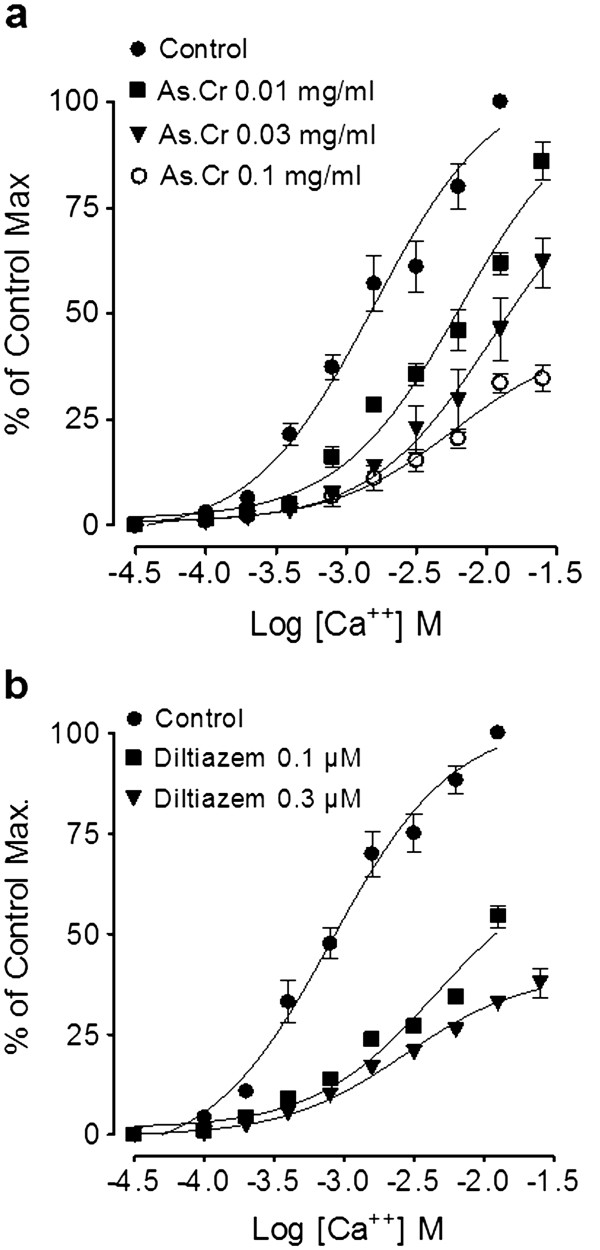
Concentration-response curves of Ca++in the absence andpresence of (a) thecrude extract ofA. spinosus(As.Cr) and (b) diltiazemin isolated rabbit trachea. Values are expressed as mean ± S.E.M., n = 3–5.